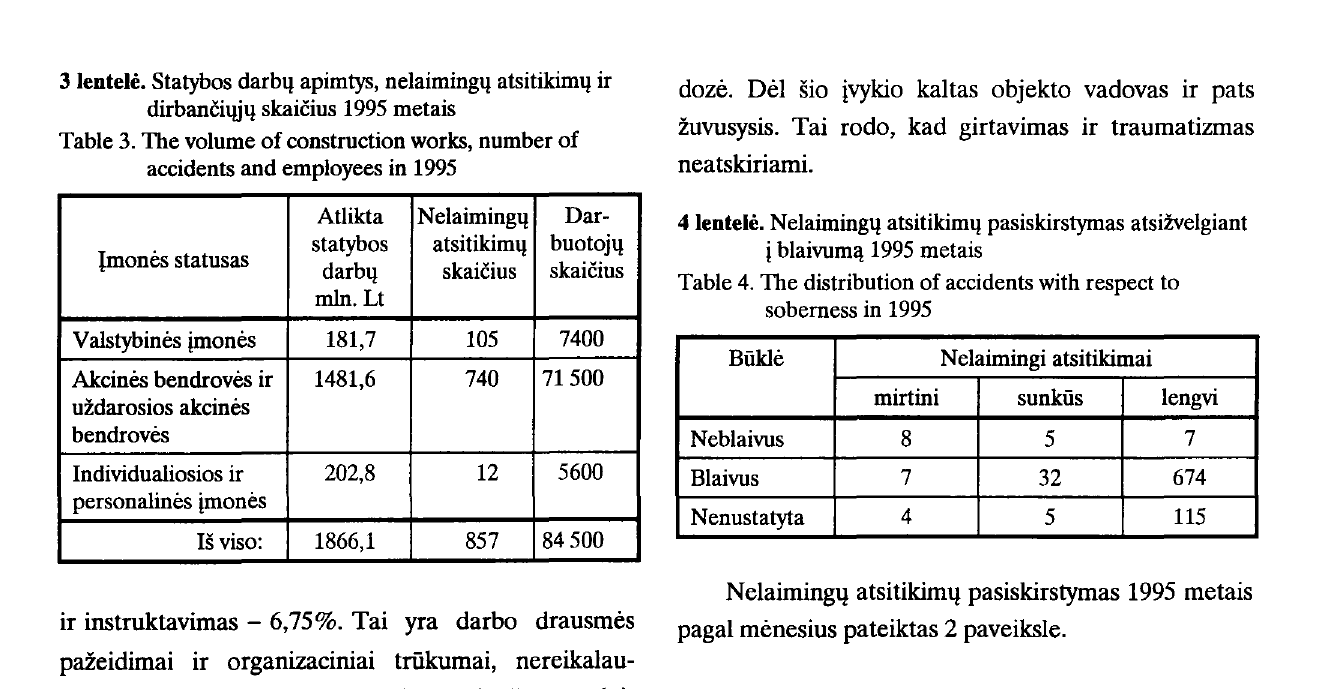
Table 3. The volume of construction works, number of accidents and employees in 1995